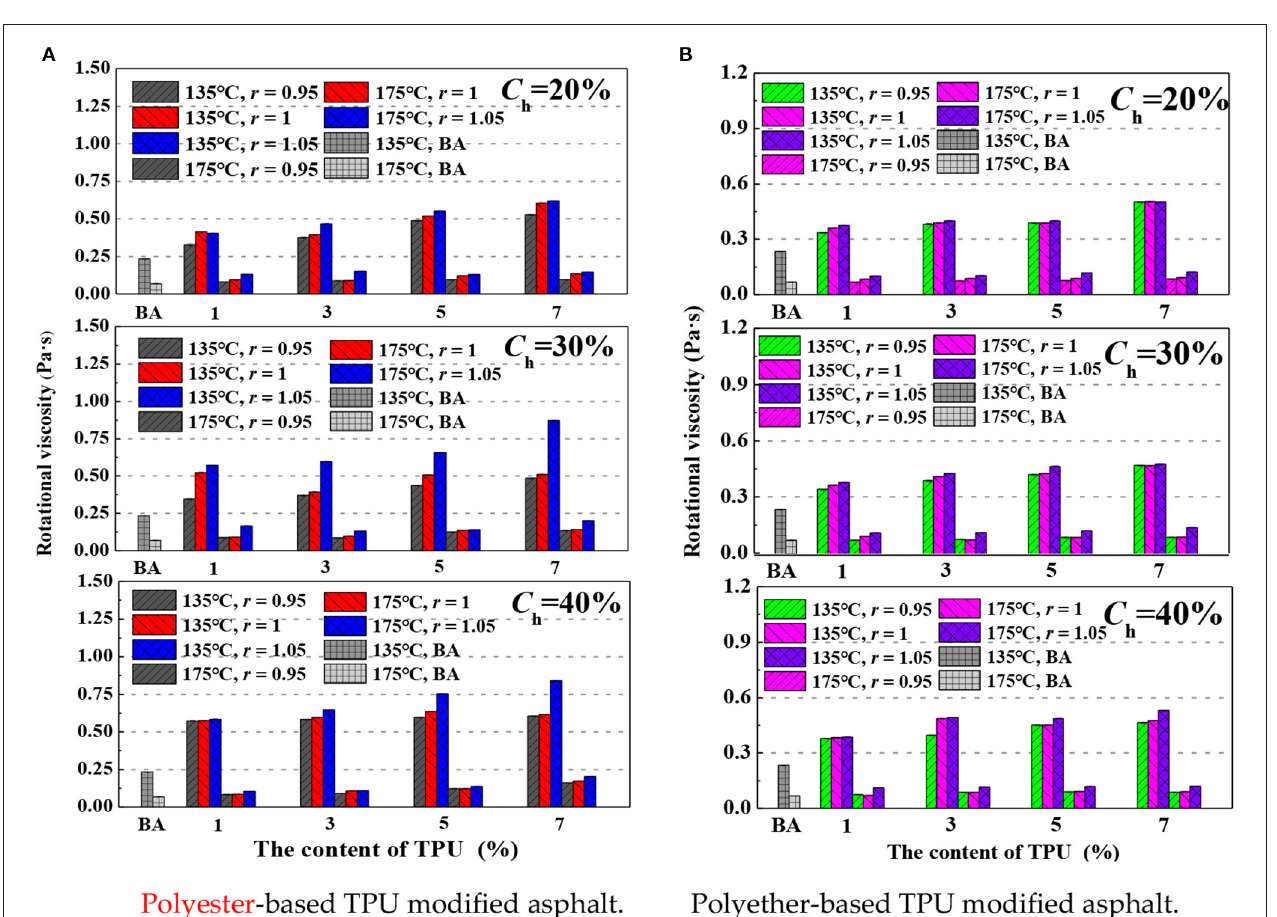
FIGURE 12 | The rotational viscosity. (A) Polyester-based TPU-modified asphalt. (B) Polyether-based TPU-modified asphalt.